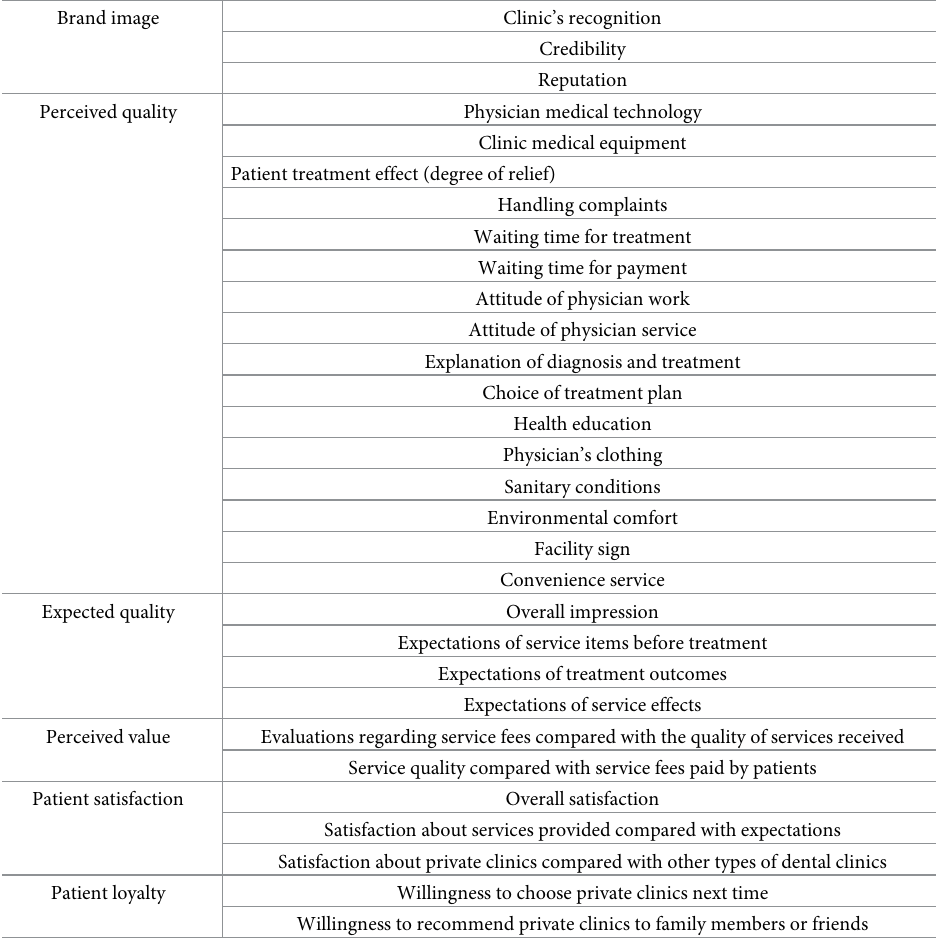
Table 1. Patient loyalty